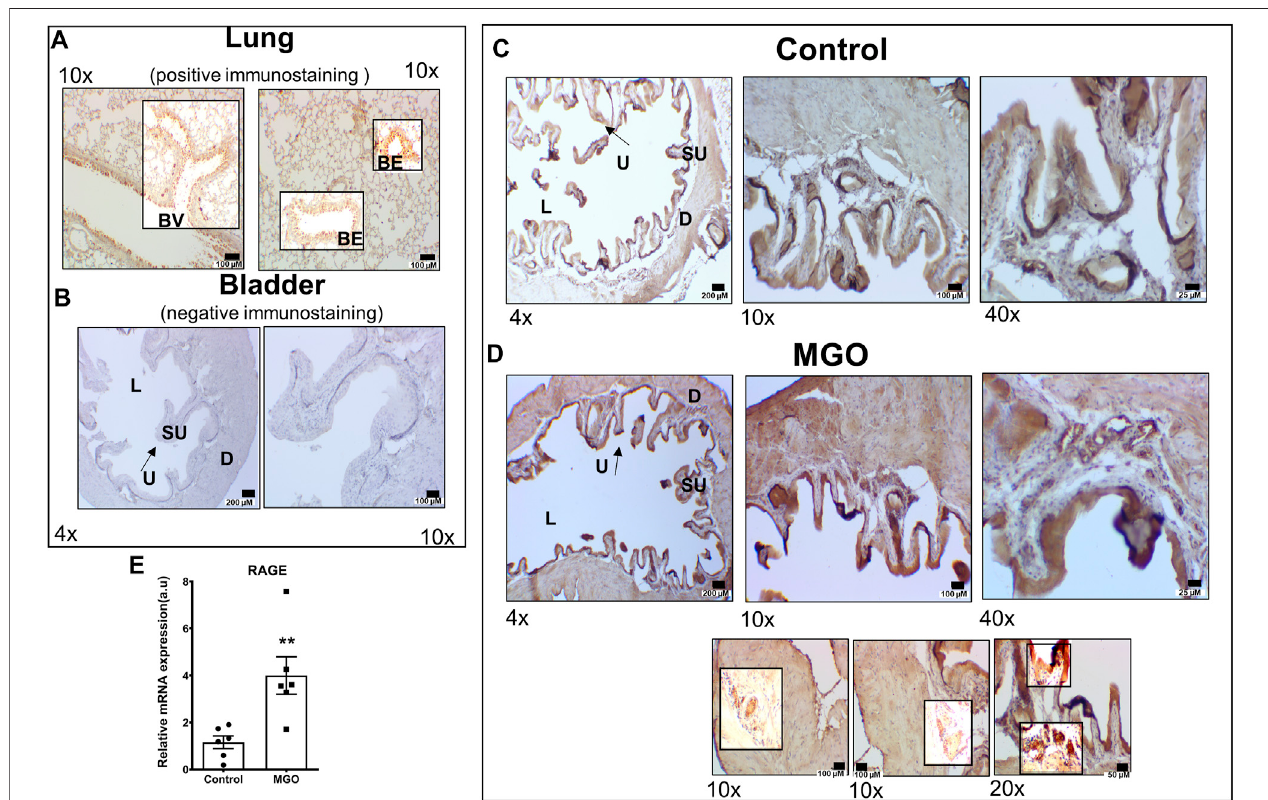
FIGURE 3 | RAGE Immunostaining and mRNA expression in control and MGO-treated mice. Panel (A) shows RAGE immunohistochemistry in lungs of healthy mice(brownstaining)aspositivecontrol,detailingthebronchialepithelium(BE)andbloodvessels(BV).Panel (B) showsnegativecontrol(omissionofantibody)inmouse bladder, detailing the urothelium (U), suburothelium (SU), lumen (L) and detrusor smooth muscle (D). Panel (C,D) show, respectively, RAGE immunoreactivity of bladder images of control groups MGO groups. The three sub-panels in panel (D) (MGO group) detail the immunostaining for RAGE in vessels supplying the detrusor and urothelium, as well as in the super fi cial layer of urothelium and vessels in sub-urothelium. In the bladder of control mice, RAGE immunoreactivity was observed in urotheliumonly,whereasinMGOgroup,astrongRAGEimmunoreactivitywasobservedinurothelium,detrusorandvascularendothelium.PanelEshowsRAGEmRNA expressionsinbladdertissueswithdataexpressedasmean±SEMofarbitraryunits(a.u.;** p < 0.01comparedwithcontrol,n=6).BlackbarsinpanelsAtoDrepresent scales of 200 μ m (×4 objective), 100 μ m (×10 objective), 50 μ m (×20 objective) and 25 μ m (×40 objective).